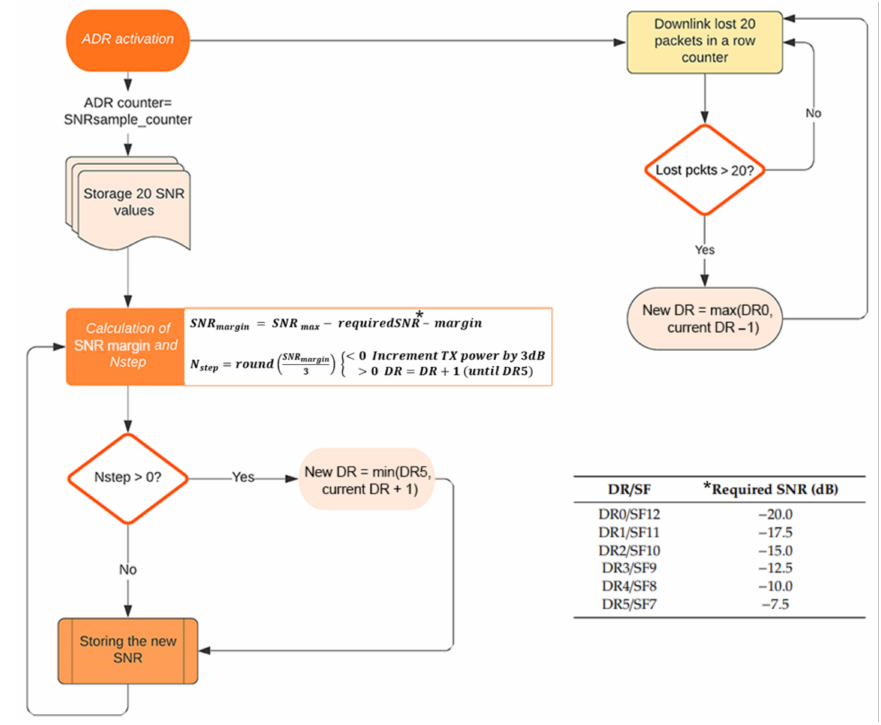
Figure 3. ADR mechanism overview for uplink as recommended by the